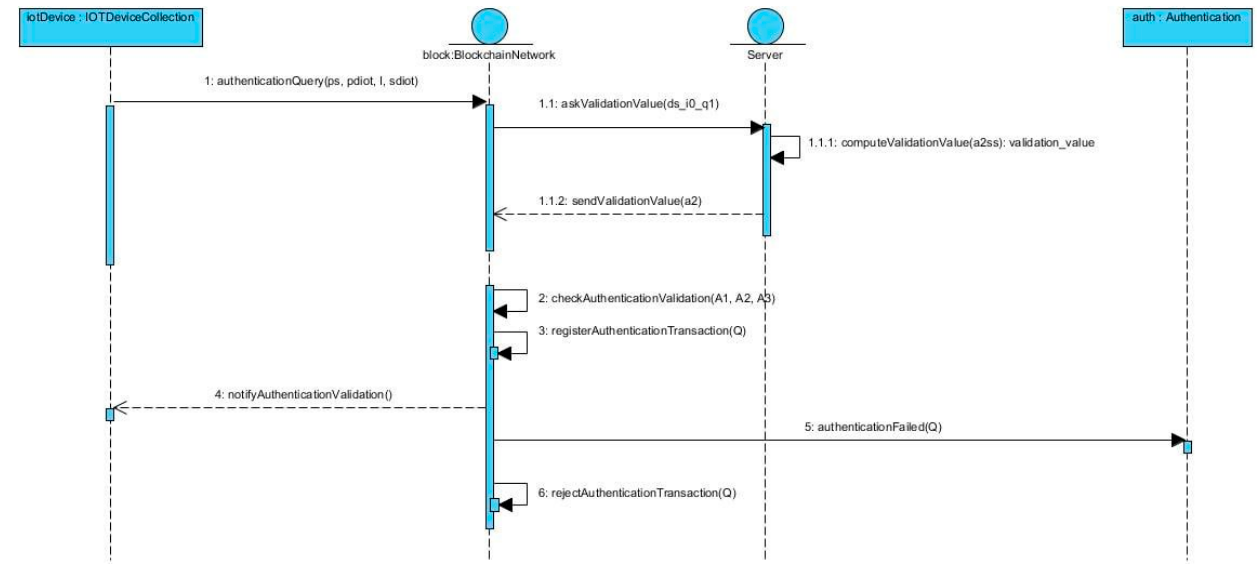
Figure 2. The authentication process.